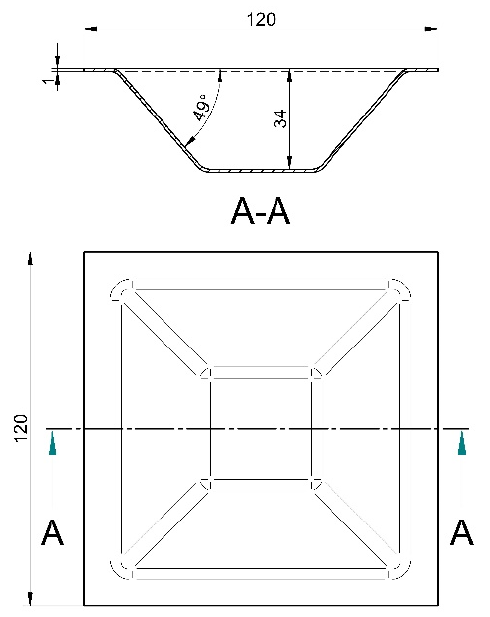
Figure 3. Geometry of a workpiece.